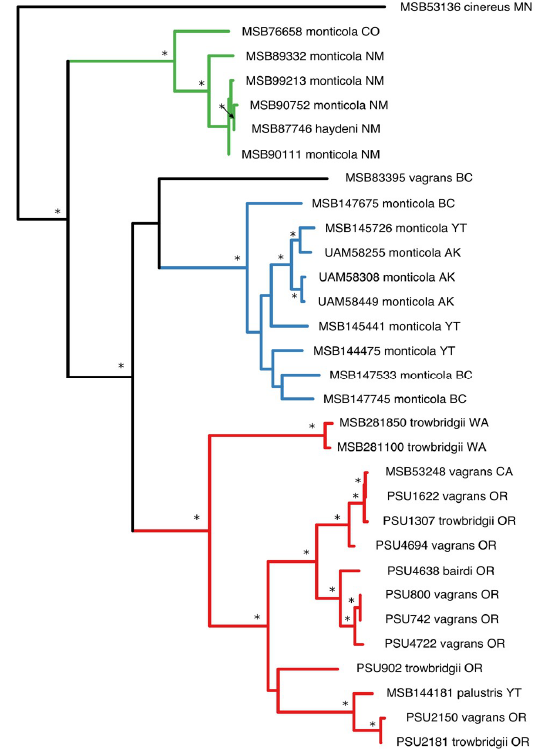
Figure 1. Maximum likelihood phylogeny of Jemez Springs virus L segment inferred using RAxML and rooted at the midpoint. Nodes with bootstrap support values greater than 70% are indicated with an asterisk. Color-coded branches correspond to geographic clades: Green = Southern Continental; blue = Northern Continental; red = Pacific Coastal. State abbreviations: AK, Alaska; BC, British Columbia; CA, California; MN, Minnesota; NM, New Mexico; OR, Oregon; WA, Washington; YT, Yukon Territory. GenBank accession numbers for the L-segment sequences are provided in Table